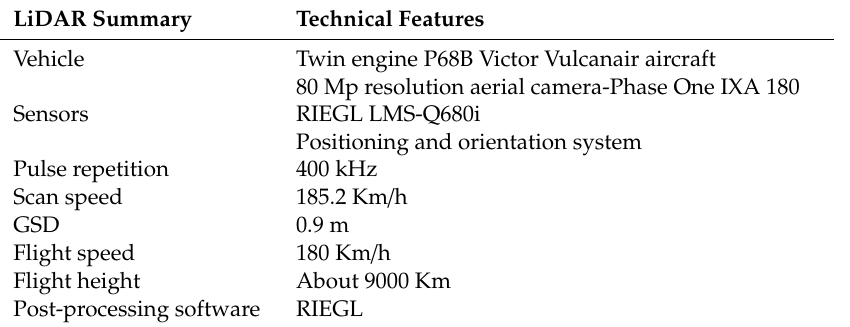
Table 2. Summary of airborne light detecting and ranging (LiDAR) information.